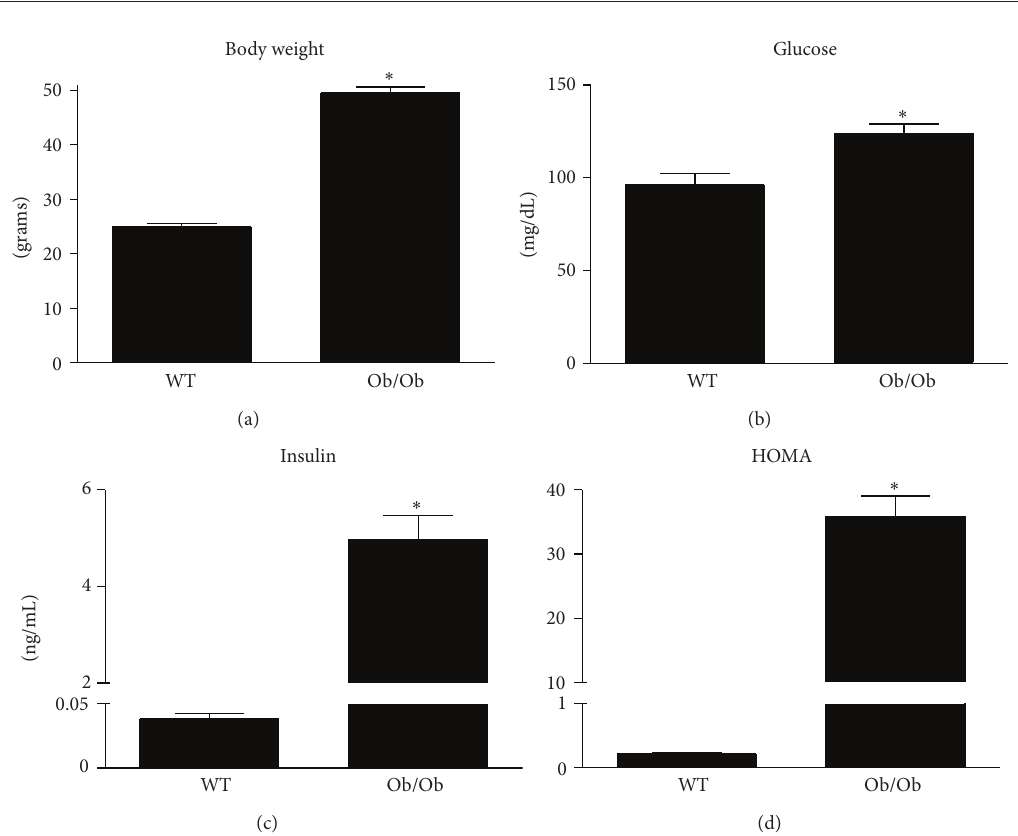
F 1: Increased body weight and reduced insulin sensitivity are characteristics of leptin de�cient Ob/Ob mice. Body weight (a), fasting blood glucose (b), fasting plasma insulin (c), and homeostasis model assessment (HOMA) (d) were elevated in 14-week-old male